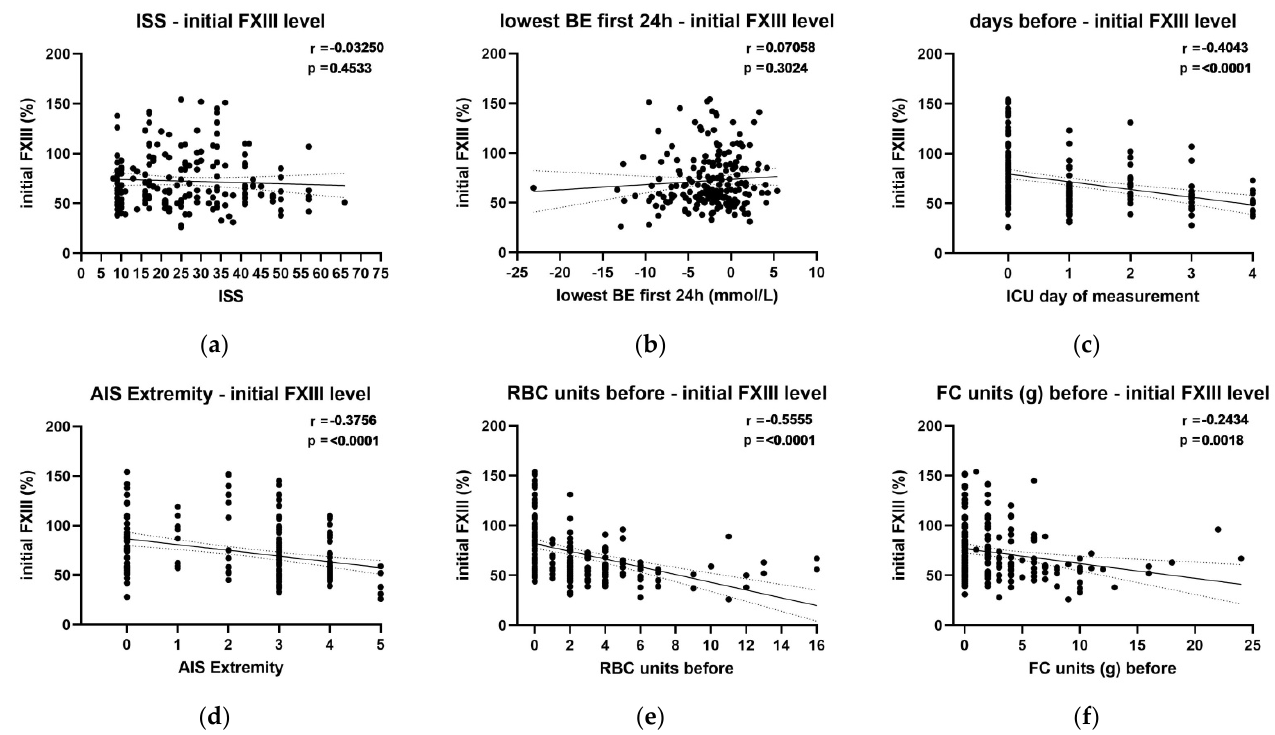
Figure 2. Correlation of highlighted determinants on the initial FXIII level. ( a ): ISS, injury severity score; ( b ): BE, base excess; ( c ): first measurement day post trauma with 0 in the first 24 h, 1 between 24 and 48 h; 2 between 48 and 72 h, 3 between 72 and 96 h, 4 between 96 and 120 h; ( d ): AIS, abbreviated injury score for the extremity region; ( e ): RBC, red blood cell concentrate; ( f ): FC, fibrinogen concentrate.